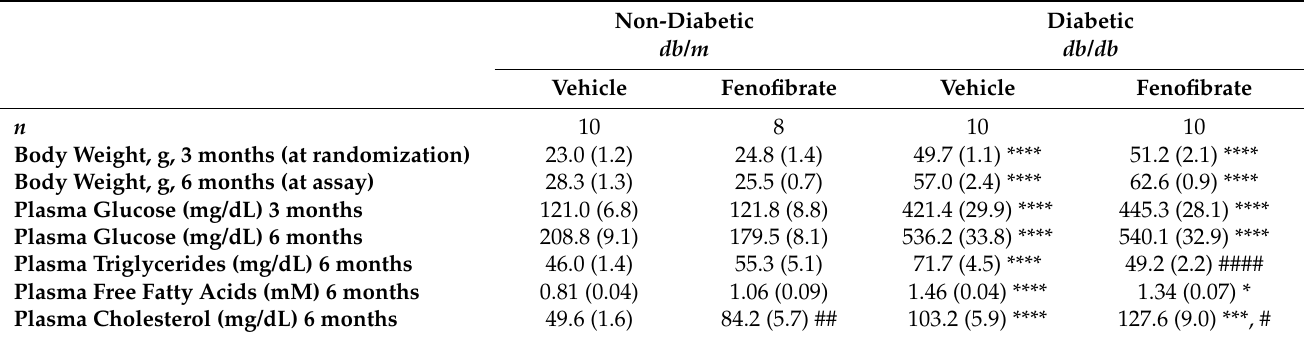
Table 2. Metabolic data of fenofibrate-treated mice in a model of type 2 diabetes. Non-Diabetic